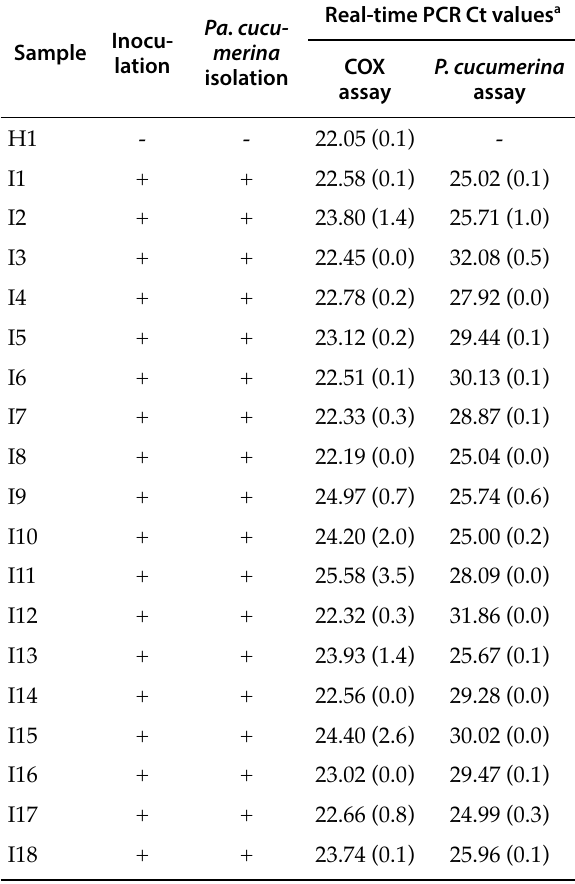
Table 3. List of healthy and inoculated rocket samples test- ed by isolation onto media and real-time PCR, targeting Plectosphaerella cucumerina DNA using the Pa. cucumerina F2/R2/P1 assay, and plant DNA using the COX F/RW/ probe